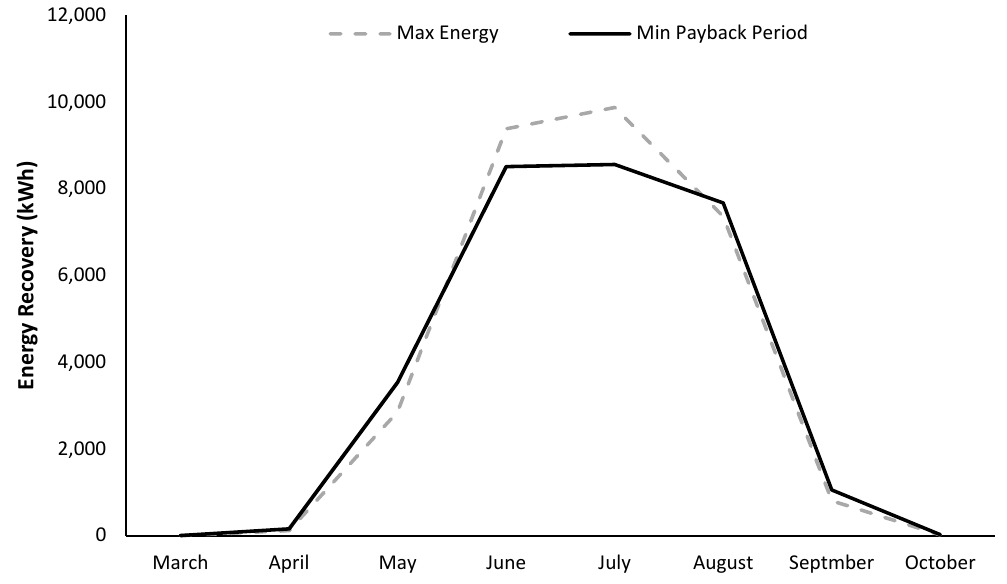
Figure 9. Comparison between the highest energy-producing scenario and the lowest PP scenario in EPP3.